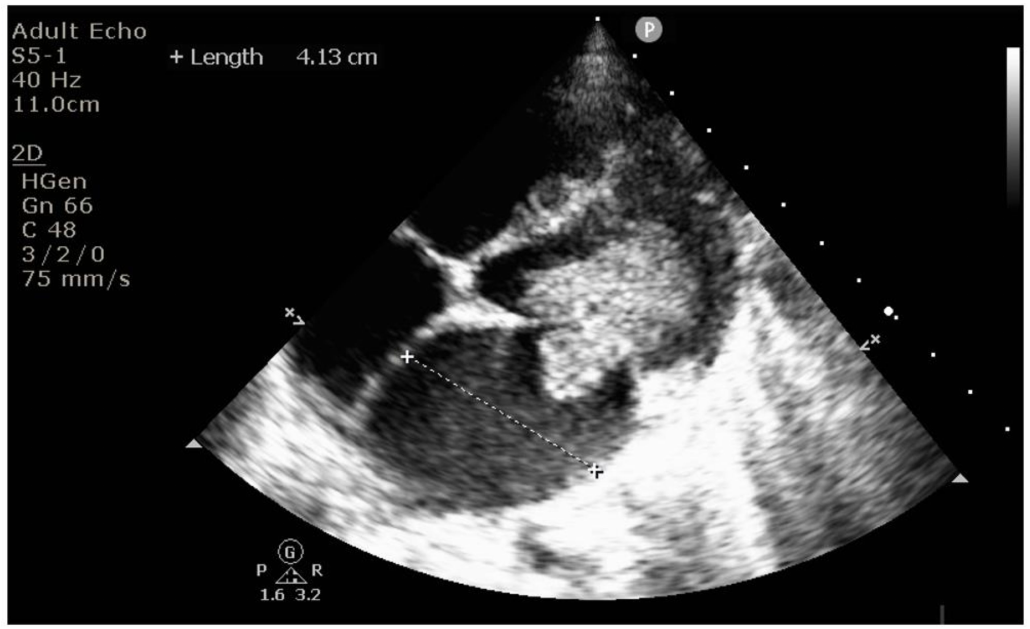
Figure 6. Dilated left atrium due to obstruction effect similar to mitral stenosis, generated by the mitral vegetation blocking the flow towards the